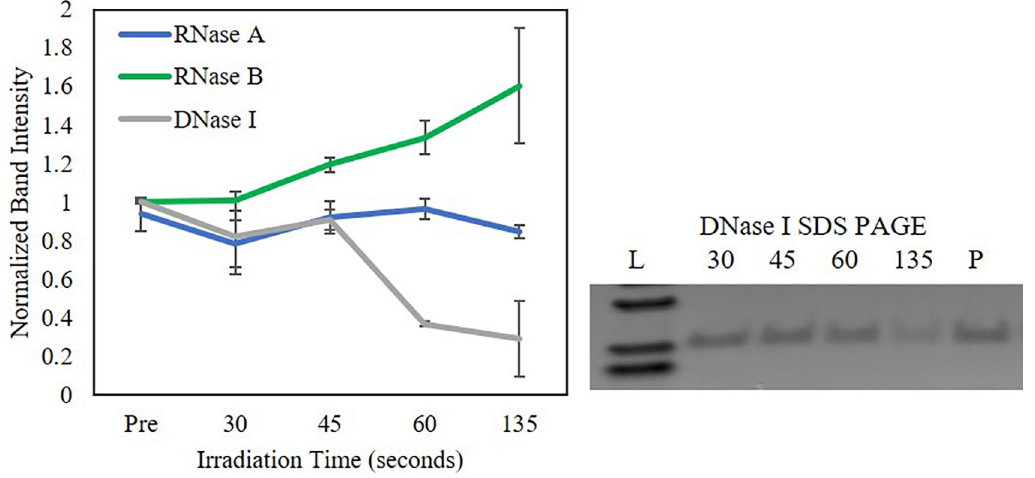
Fig 1. SDS PAGE band intensities for RNase A, RNase B, and DNase I in 1 mM Tris-EDTA post 30% microwave irradiation with Lyse-It. A representative SDS PAGE for DNase I is provided were a decrease in band intensity is seen as microwave irradiation time increases. For RNase A and B, the band intensities did not decrease as irradiation time increased and thus, there were no statistical differences for RNase A and B.